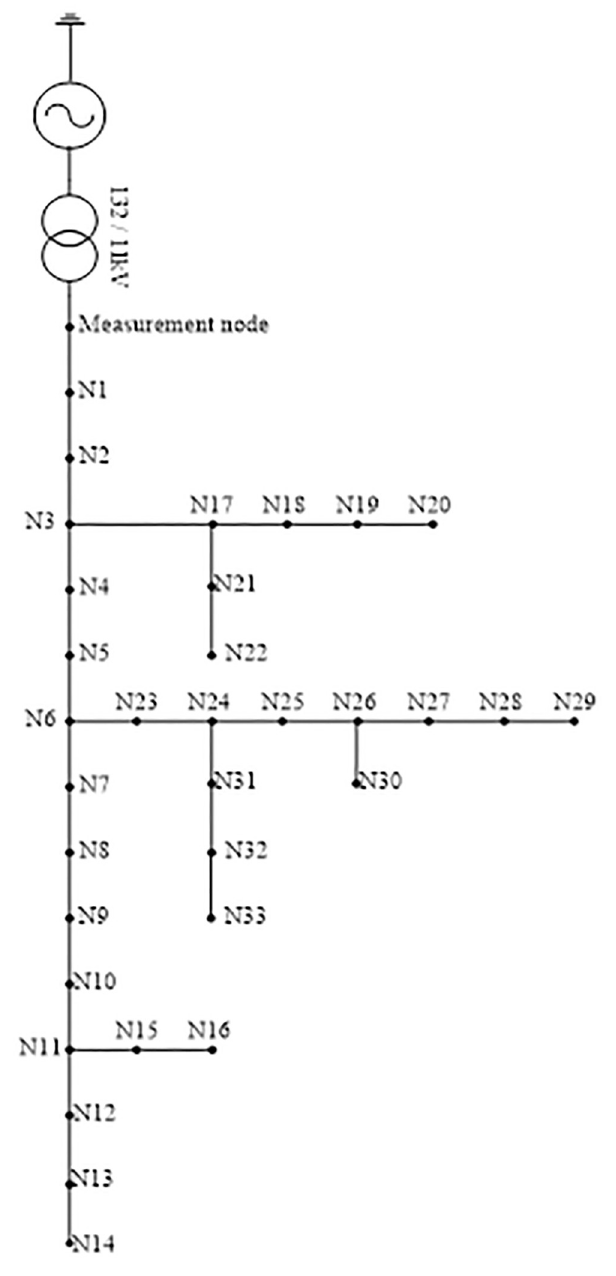
Fig 10. Distribution network consists of 33